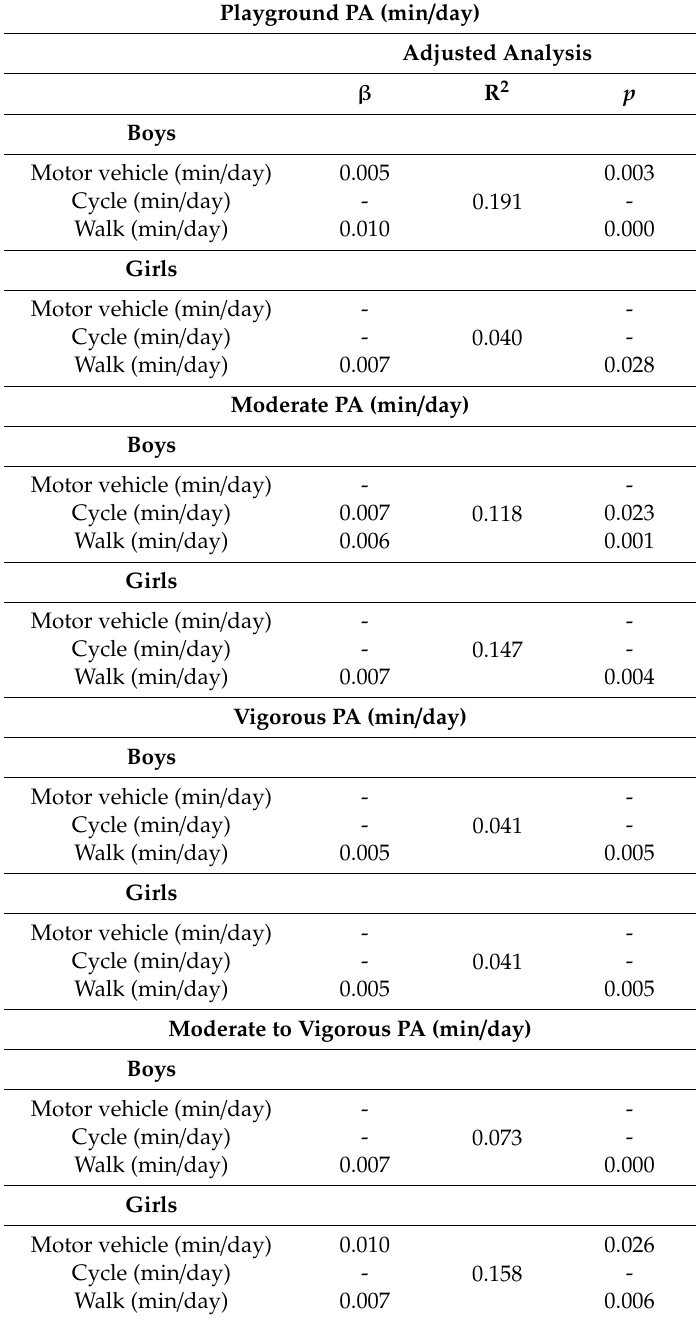
Table 3. Association between AC and non-AC with PA levels divided by